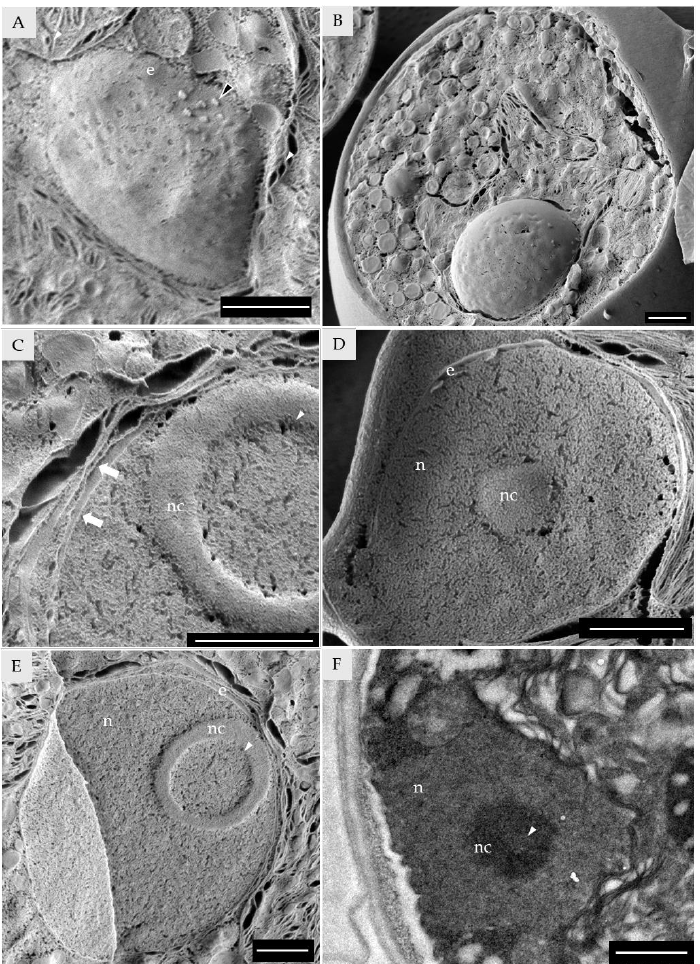
Figure 6. LTSEM ( A – E ) and TEM (F) of Trebouxia lynnae nuclei. ( A ) Surface of a whole nucleus. ( B ) Nucleus inside the chloroplast pocket. ( C ) Double membrane of the nuclear envelope of a fractured nucleus. ( D ) Fractured nucleus with a whole nucleolus. ( E , F ) Nucleus with a fractured (sectioned) nucleolus with a nucleolar vacuole. Nucleus (n), nucleolus (nc), and nuclear envelope (e) are indicated with letters. The nucleolar vacuole is indicated by a white arrowhead. Material that accumulates at the surface of the nuclear pore is indicated by a black arrowhead. Inner and outer membranes of the nuclear envelope are indicated by white arrows. Scale bars: ( A – F ) 1 µ